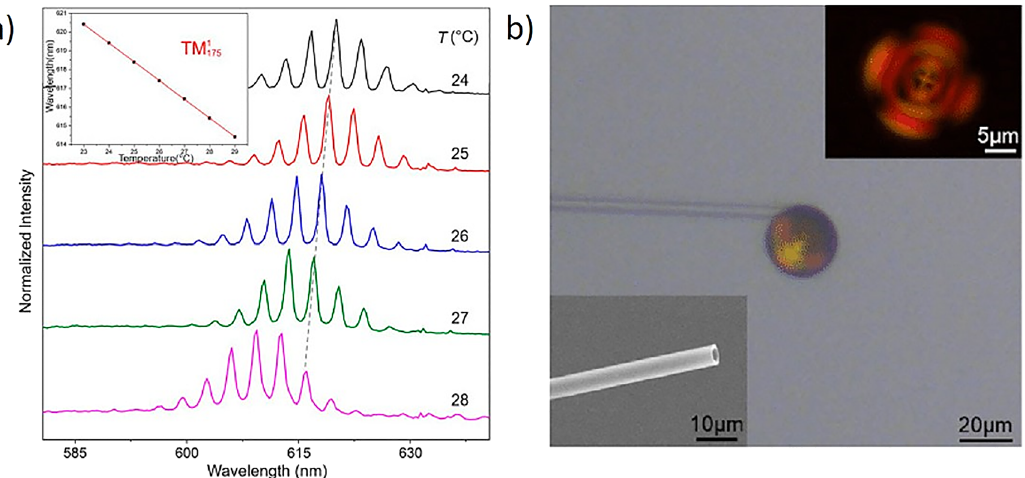
Figure21: (a)Lasingspectrumof 22 μ mCLCmicrodroplet as afunctionof temperaturefrom 24to 28 ° C.Inset: temperature dependenceof the lasingwavelengthsoftherepresentativemodeTM 175 .Thewavelengthsexhibitedanalmostlinearrelationshipwithtemperature(0.95nm/ ° C); (b) Micrograph of a 20 μ m dye-doped CLC microdroplet con fi ned at the tip of a capillary microtube. Insets: close-up POM image of the microdroplet (upside); SEM image of the microtube (underside) [157].